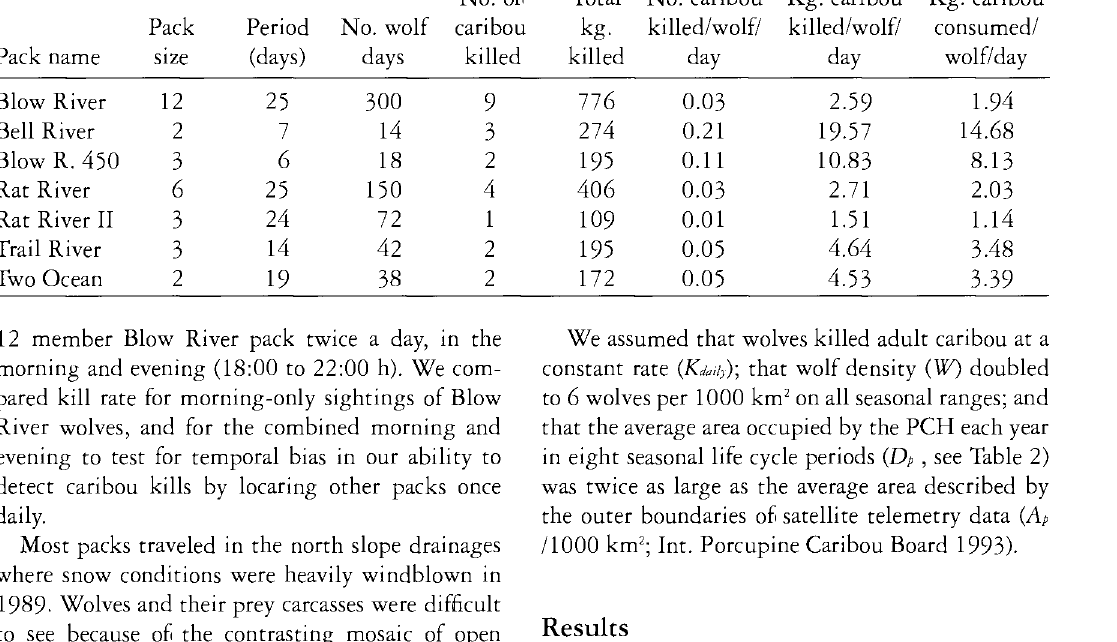
(Table 1). Traveling pack size was 4.4 ± 1.4,